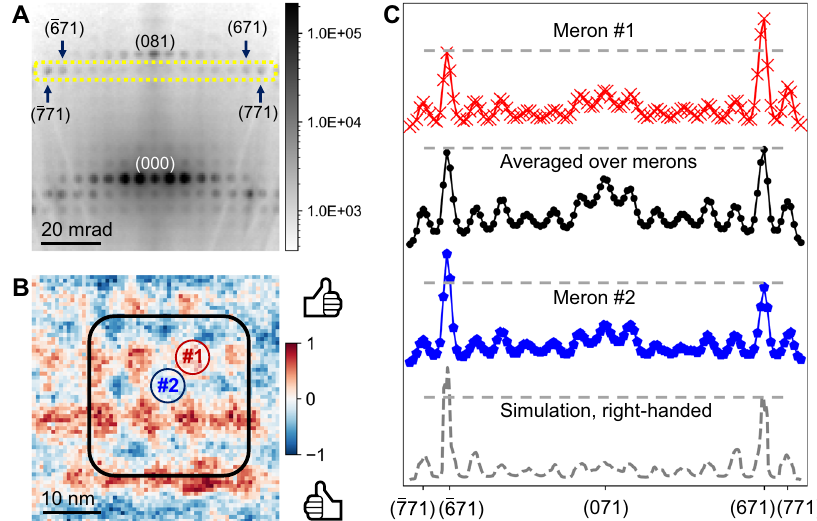
Fig.5|Measurementofhandednessofthechiralpolartexturesusing4D-STEM. A A representative experimental diffraction pattern acquired at 373K (from the meron square lattice phase), oriented ~6.2° away from [001] zone axis, and tilted along one of the mirror planes. B Map of normalized intensity difference between (771) and ( (cid:1) 771) re fl ections reconstructed from the 4D-STEM dataset — i.e. one dif- fraction pattern is recorded at each spatial pixel in B . The positive (negative) regions indicate the polar textures having left-handed (right-handed) chirality. C Intensitylinepro fi lesofHOLZre fl ectionsfromdiffractionpatternstakeninfrom